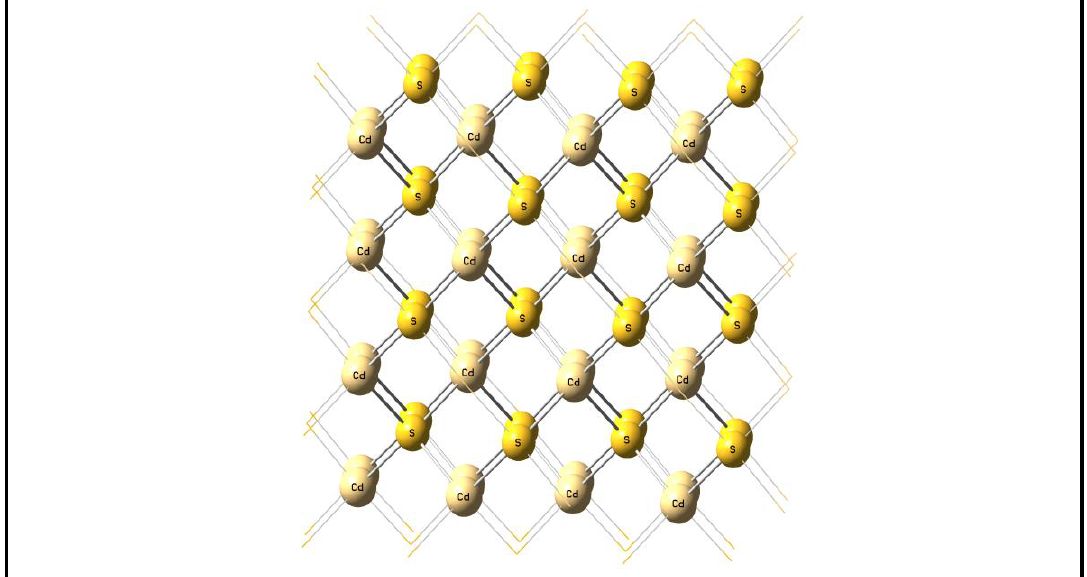
Fig. 2: (color online) CdS 64 atoms core LUC (cubic Bravais cell